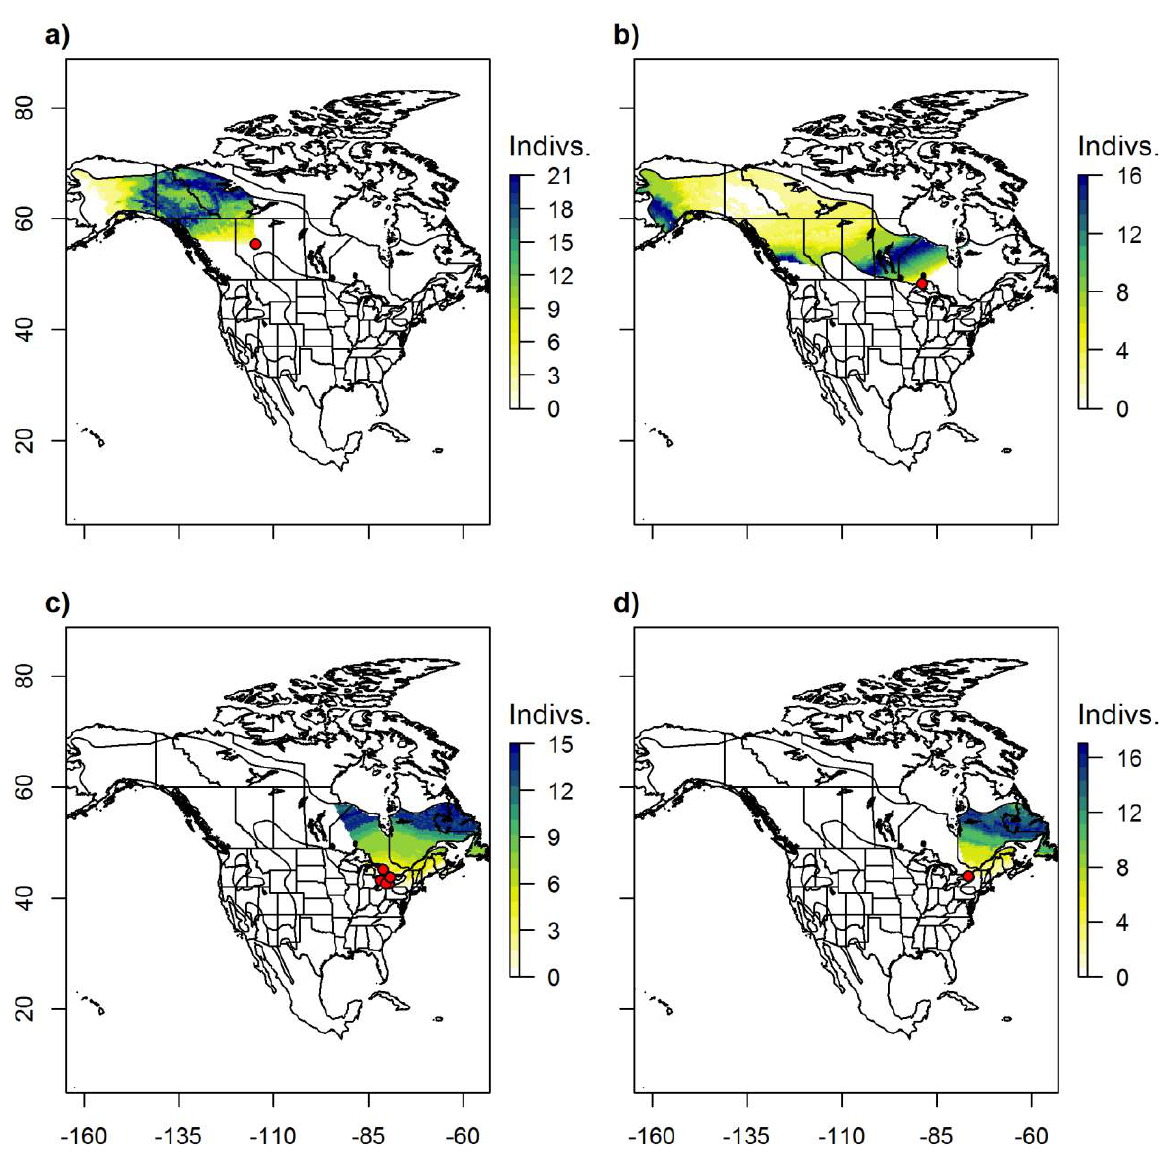
Figure A2.19: Probable origins of Yellow-rumped Warblers ( Setophaga coronata ) captured during spring migration at CMMN stations in a) Northern Alberta (LSLBO (n=25)); b) Western Ontario (TCBO (n=23)); c) Southwest Ontario (AuBO (n=5), BPBO (n=5), HBO (n=5), LPBO (n=5), TTPBRS (n=5)); and d) Southeast Ontario & Southwest Québec (PEPTBO